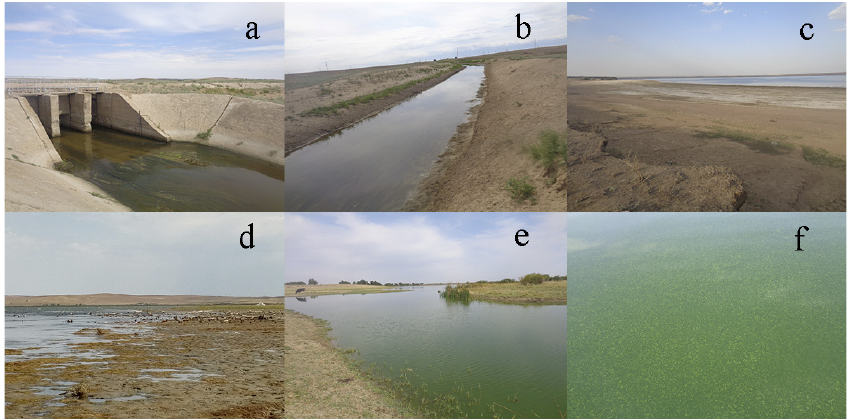
Figure 2. Wastewater canal 6 km upstream of the confluence with Sorbulak ( a , b ), the coastal zone of Sorbulak ( c , d ), RSC 8 ( e ), suspension of cyanobacteria in RSC 7 ( f ). Photos by E.